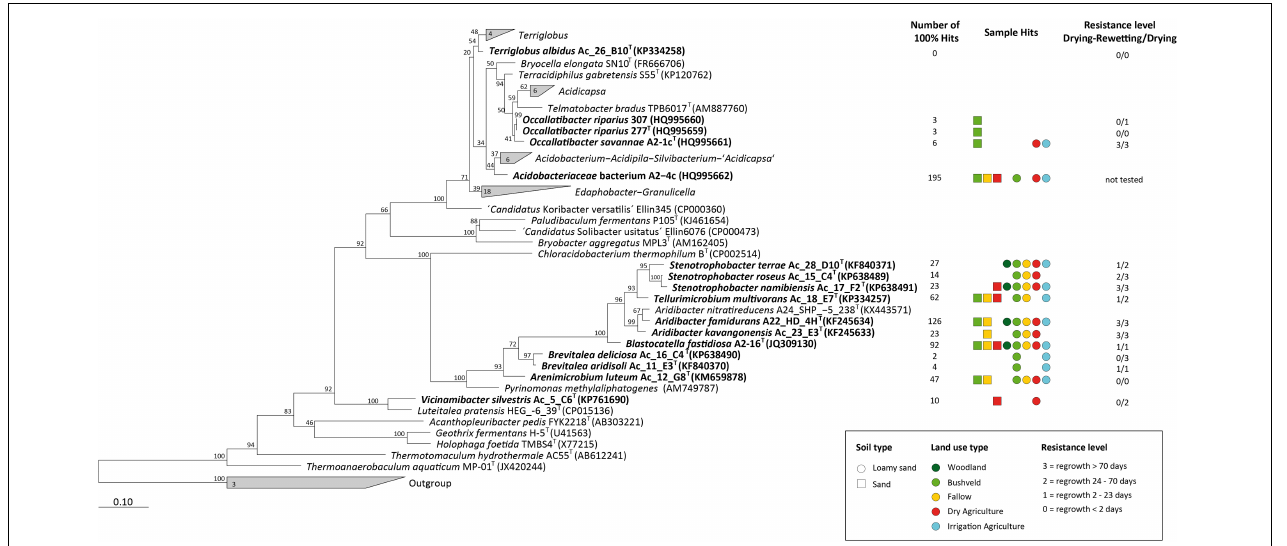
FIGURE 6 | Maximum-likelihood phylogenetic tree (numbers at nodes give percentage of 1,000 bootstrap replicates) of all known acidobacterial isolates with (validly) published names acidobacterial isolates. Numbers in wedges give total numbers of isolates available for the respective genera. The 16 isolates retrieved from Namibian soils are highlighted in bold. Number of 16S rRNA transcripts of these isolates that were detected in sequence datasets from different soils by BLAST (at a 100% identity level), the corresponding land use and soil types, and the type of resistance of the isolates are indicated on the right.